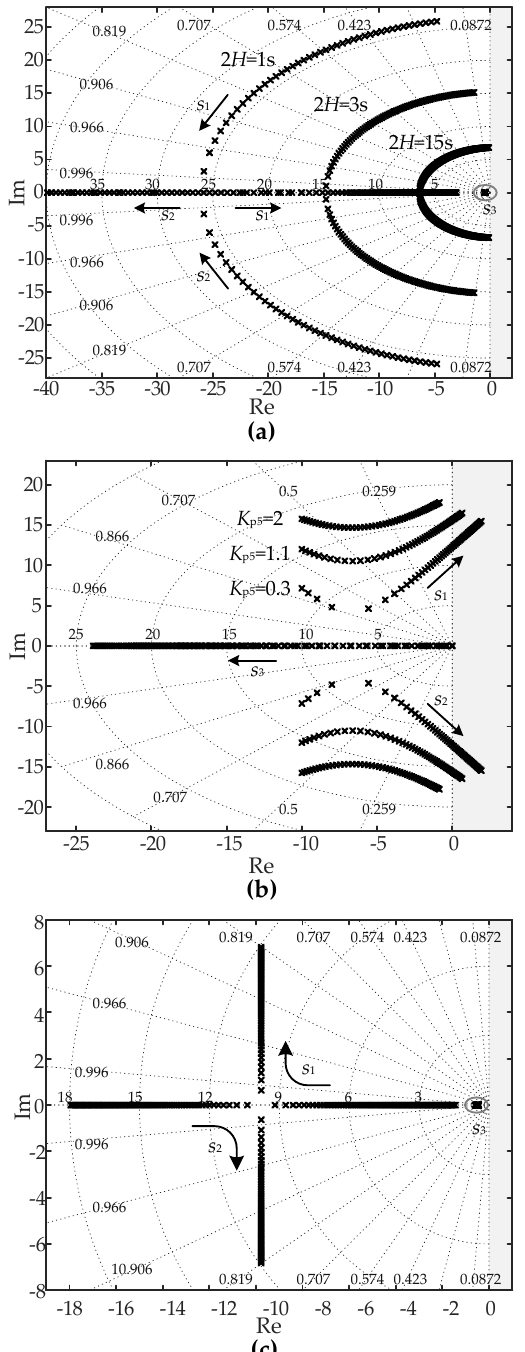
Figure 5. Family of root loci for variations of: ( a ) H and D + K ω ; ( b ) K p and K i ; ( c ) K S .